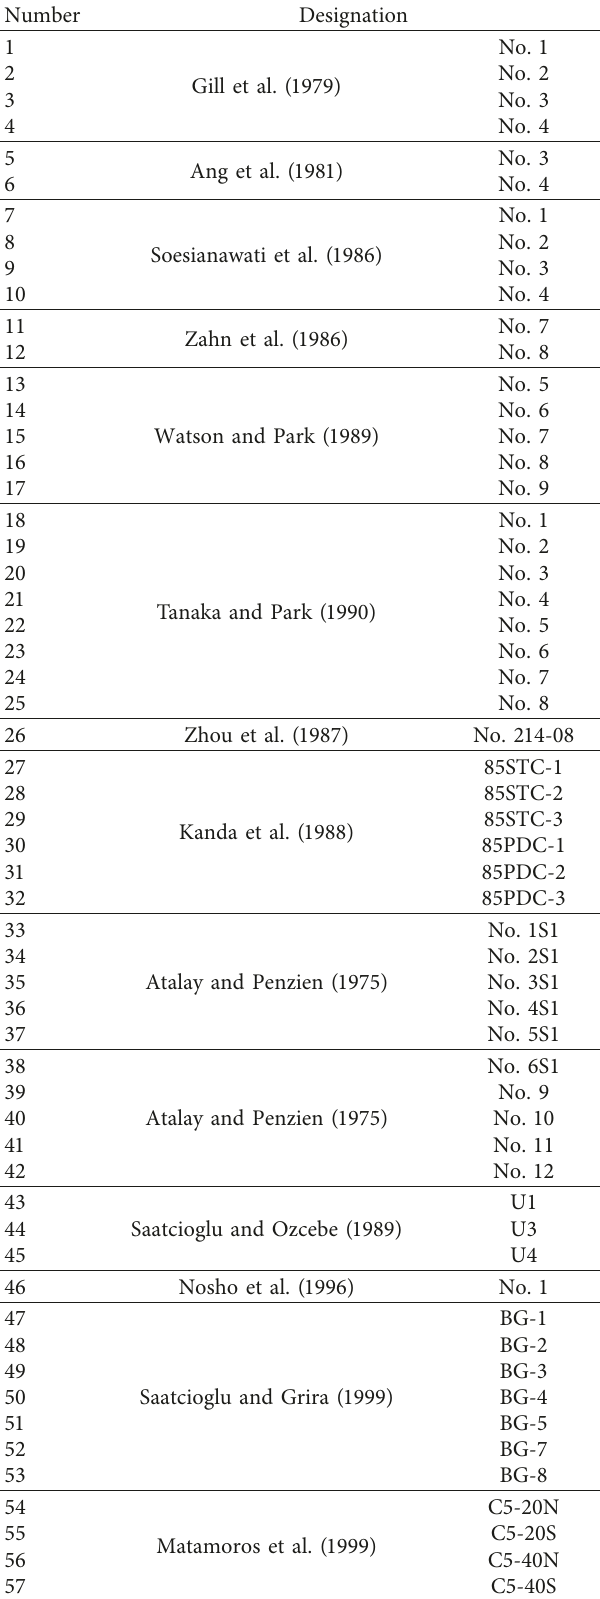
mentioned parameters, 73 flexure critical RC columns with square cross section were selected from the PEER database as tabulated in Table 1 for analysis. The criterion of selection is that the hysteretic loops should be “regular” and their lower and upper branches are approximately symmetric about the origin of the coordinate system. Figure 4 plots the relationship between x and x , where x is the normalized residual 2 1 2 displacement corresponding to the lateral load reducing to zero. The following power function is derived through nonlinear regression analysis for describing the relationship between x and x : 2 1